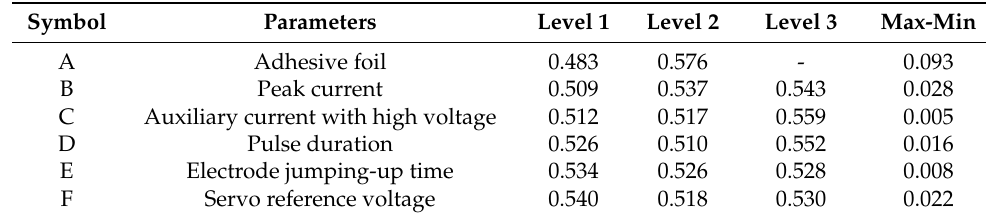
Table 13. Performance table for the relative closeness value.